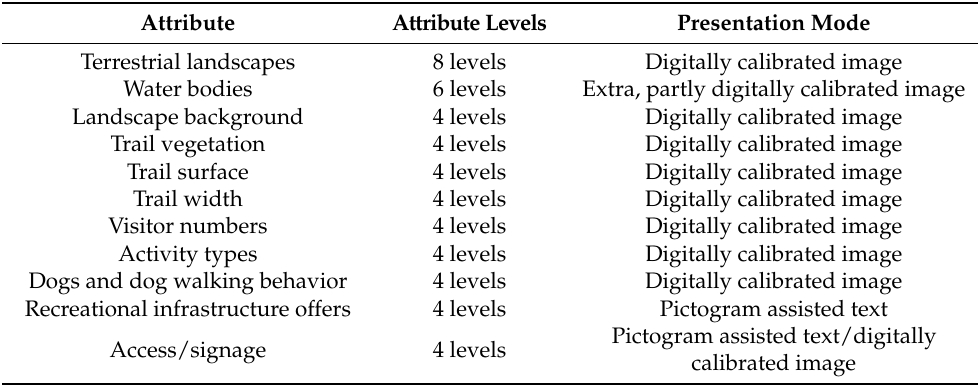
Table 1. Eleven attributes and their levels and mode of